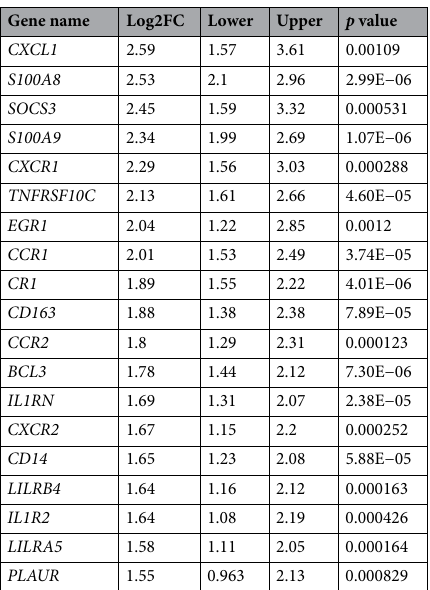
Table 1. Top 20 differentially expressed genes identified by NanoString analyses in PBMCs obtained the day-of-surgery (DOS) and at 24 h after surgery (POD1) from 5 patients undergoing total knee arthroplasty for knee osteoarthritis, with Log2 fold-change > 1.5 and p < 0.05. Log2 FC = Log2 fold change (POD1-vs-DOS). Lower = Lower confidence limit (log2). Upper = Upper confidence limit